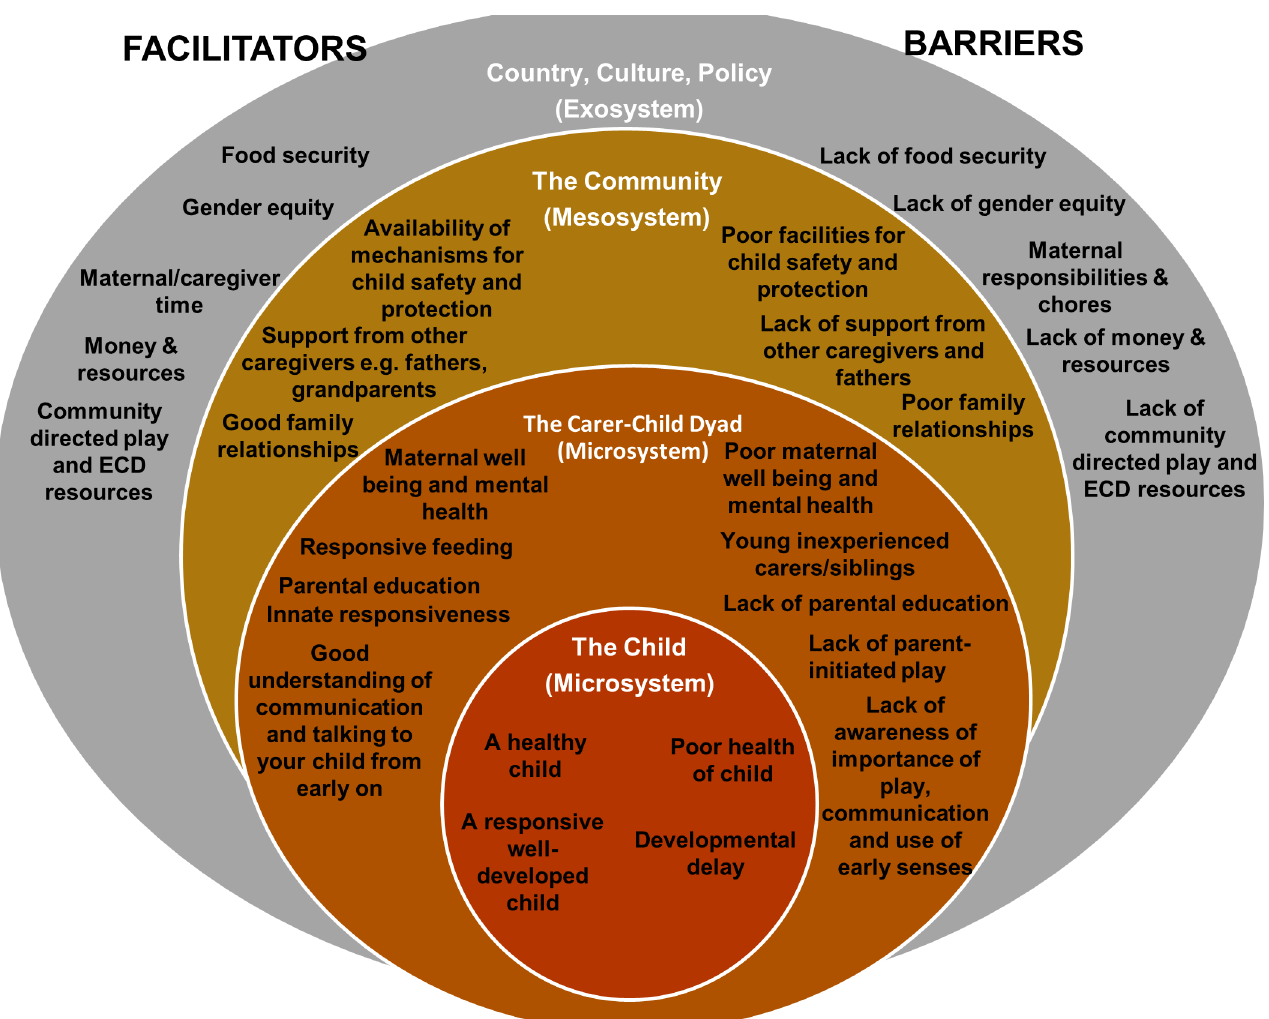
Fig 1. Facilitators and barriers relating to play, developmental stimulation, early communication and responsiveness within the ecological framework for children from 0–2 years in rural and urban contexts in